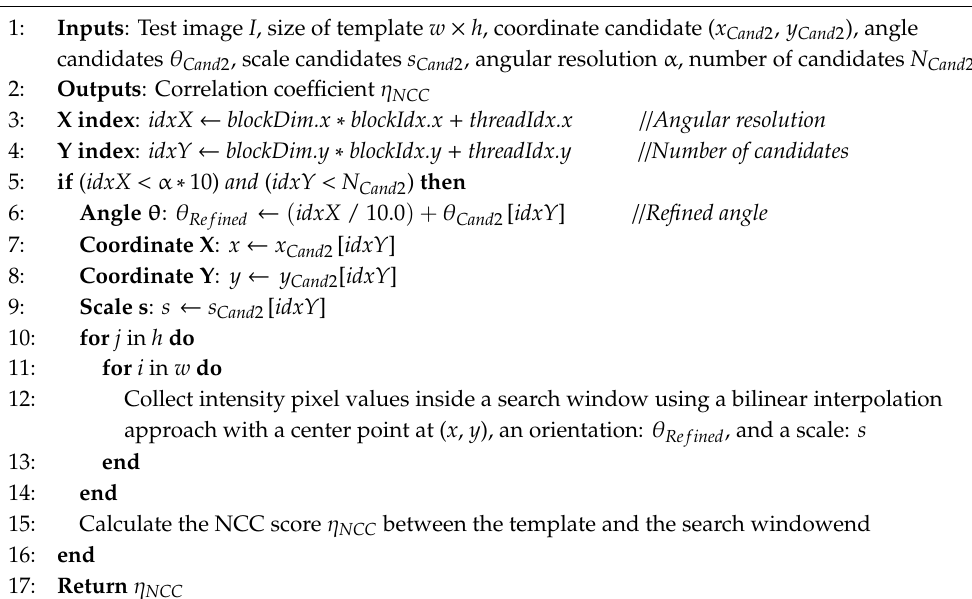
Algorithm 2 Pseudo-code of rotation angle refinement